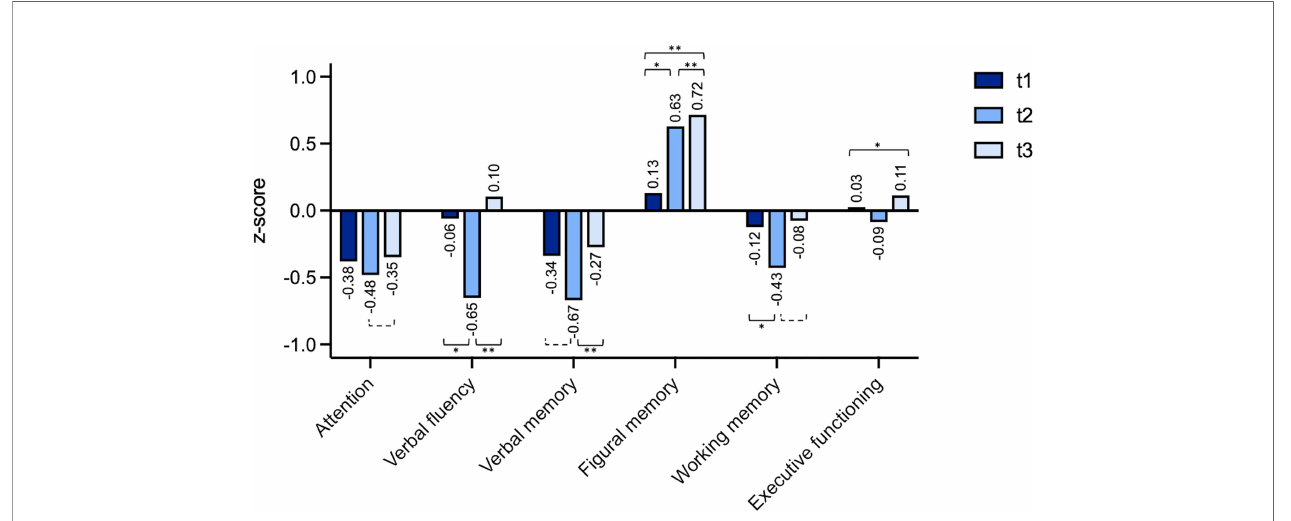
FIGURE 2 | Individual changes (z-scores) t1 (preoperatively), t2 (after a median follow-up period of 4.1 months) and t3 (after a median follow-up period of 18.3 months). The domain “ visuospatial functioning ” was excluded because the underlying test has no variance of the standardized value in the performance range rated as unimpaired. *=p < 0.05, **=p < 0.01, dashed bracket p <